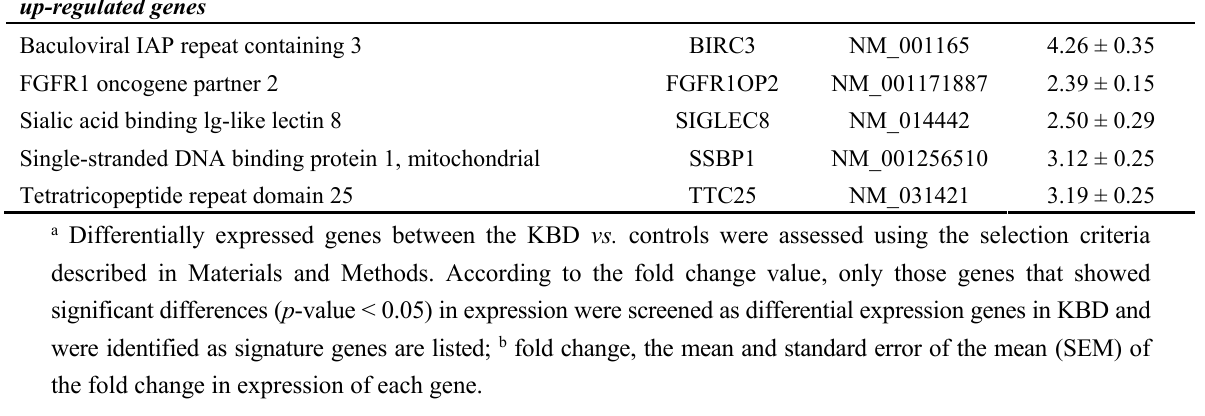
Table 2. Results of Bayes discriminant analysis (BDA) with the expression ratio of signature genes b,c